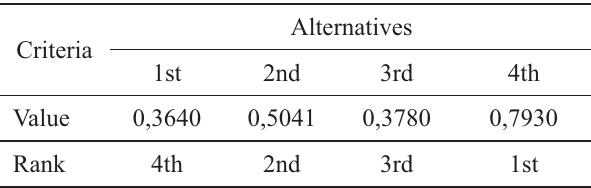
Table 6. The results obtained in multicriteria evaluation of the considered object’s